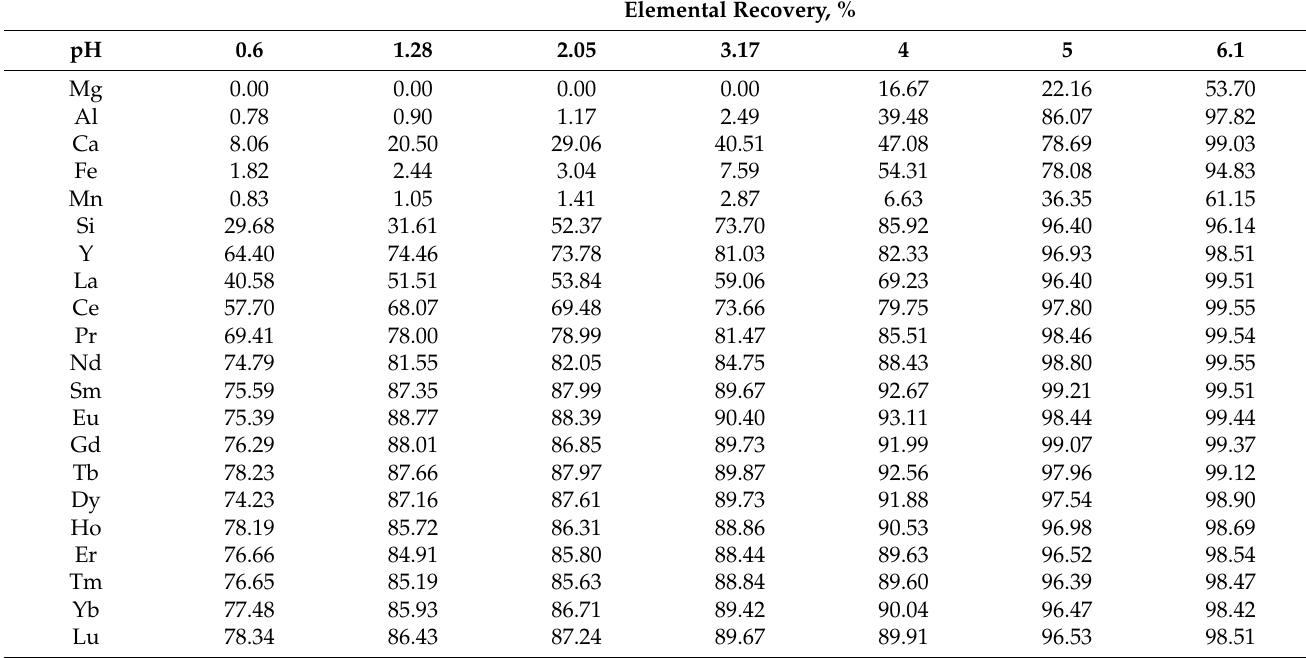
Table 6. Elemental recovery of rare earth elements and contaminants (Al, Ca, Fe, Mn, Si) at a fixed dosage of 15 g/L and reaction time of 1